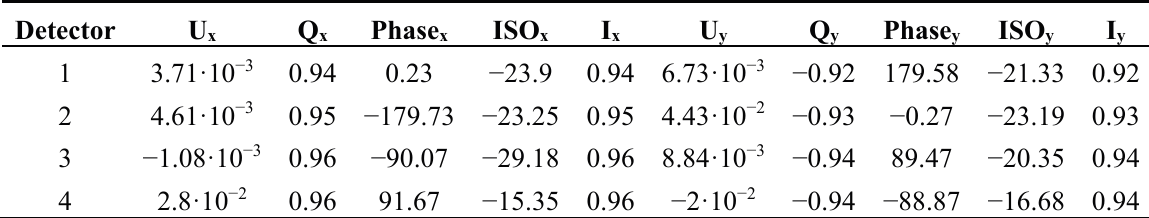
Table 5. Parameters calculated from the detected signals shown in Figure 6 (Phase in Deg. and ISO in dB).